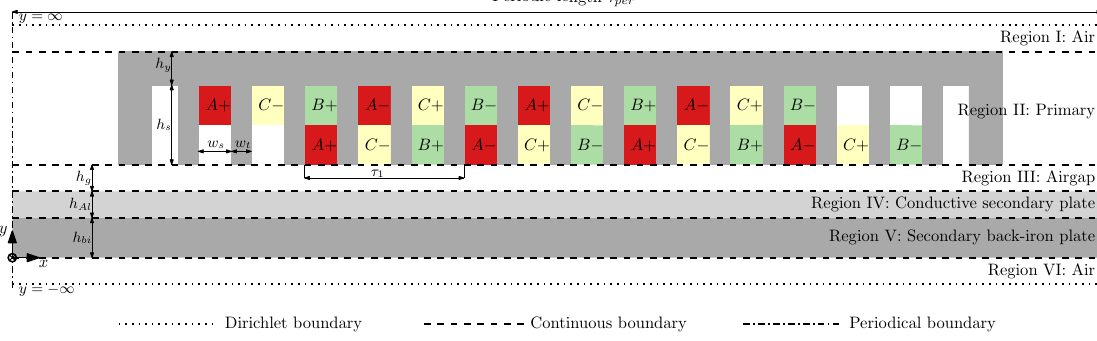
Figure 2. LIM topology: division into regions, dimensions, and considered boundary